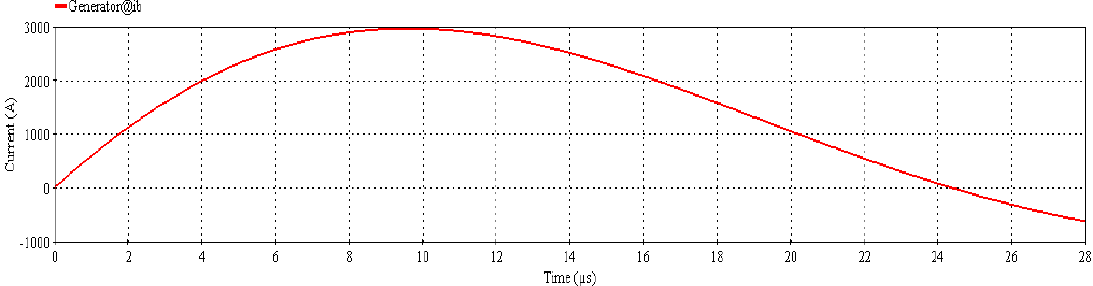
Figure 13. The short-circuit current waveform of 3 kA.